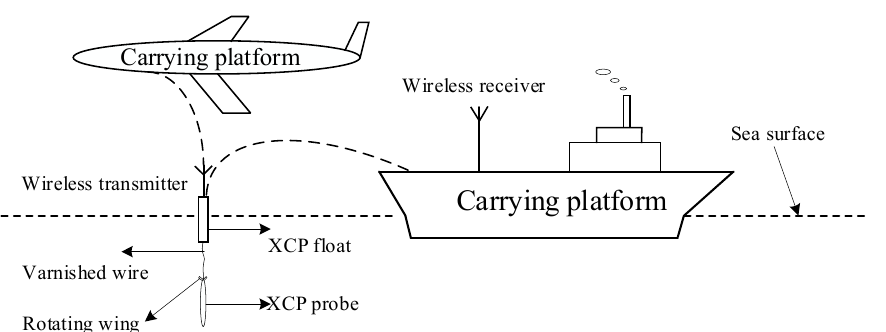
Figure 1. XCP is released and work diagram. Rotating wing: makes the probe rotate down. Varnished wire: transfers data. XCP float: wireless transmitter and probe release. Wireless transmitter and wireless receiver: wireless transmission and reception of data.